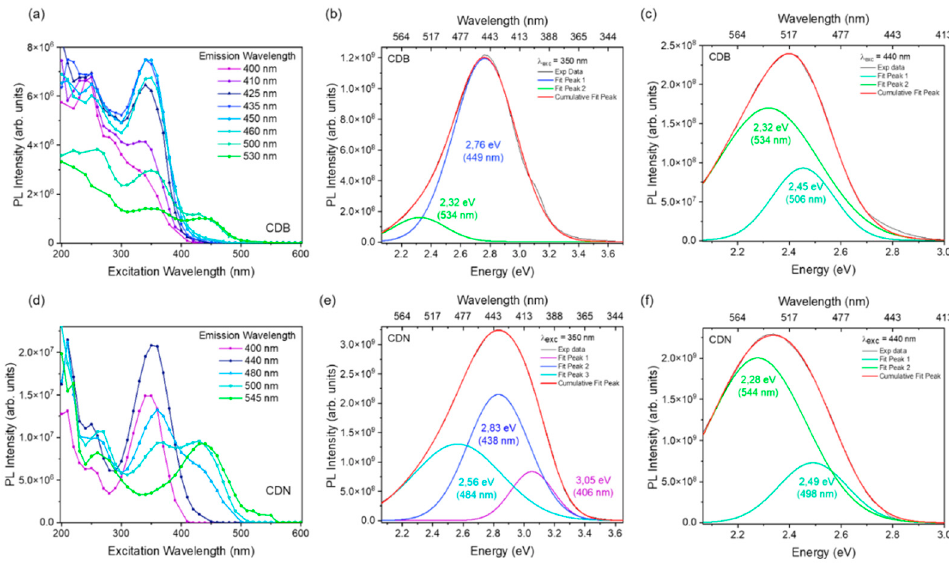
Figure 10. ( top ) PLE ( a ) and PL spectra at 350 ( b ) and 440 nm ( c ) of CDB sample. ( down ) PLE ( d ) and Figure 10. (top) PLE ( a ) and PL spectra at 350 ( b ) and 440 nm ( c ) of CDB sample. (down) PLE ( d ) PL spectra at 350 ( e ) and 440 nm ( f ) of the CDN and PL spectra at 350 ( e ) and 440 nm ( f ) of the CDN sample.